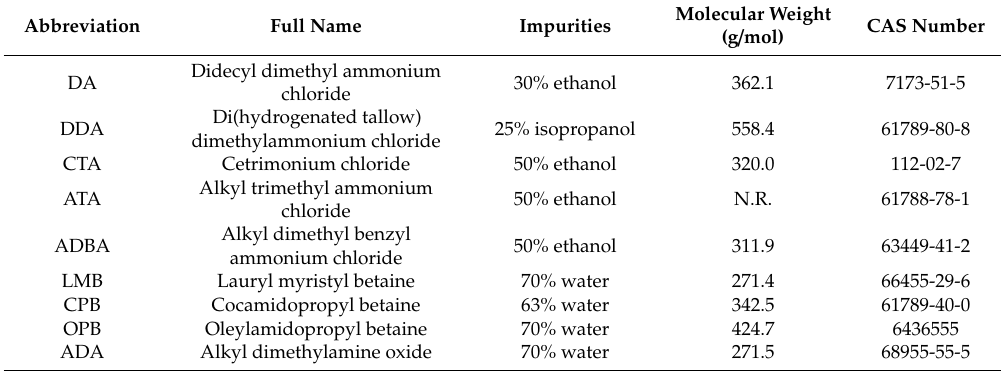
Table 1. The properties of used